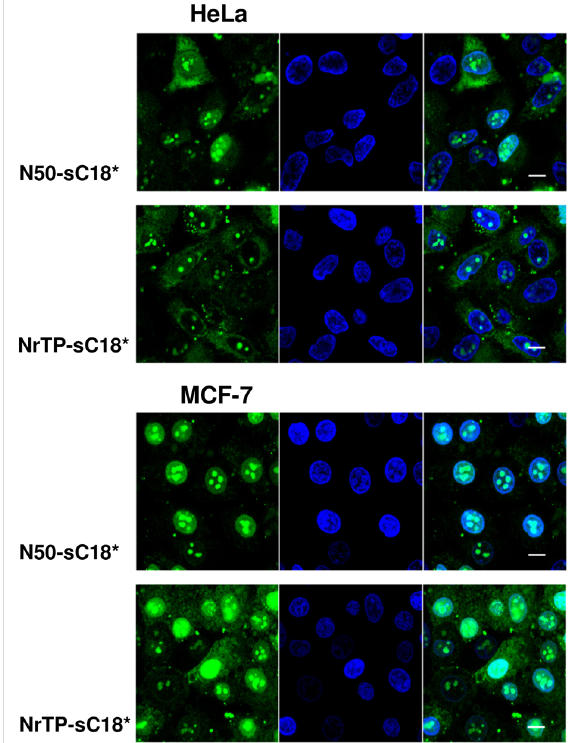
Figure 6: Cellular uptake in HeLa and MCF-7 cells when incubating the cells at 4 °C for 30 min with the CF-labeled chimeric peptides (10 µM). Green: CF-labeled peptide; blue: Hoechst 33342 nuclear stain; scale bar is 10